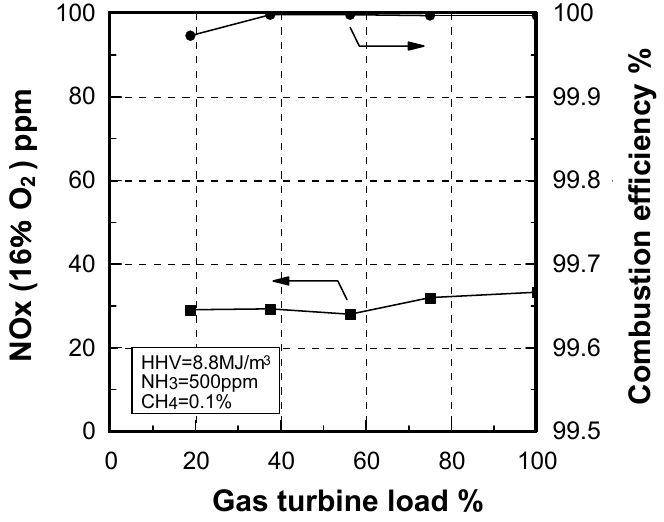
Figure 85. Effect of the gas turbine load on combustion emission